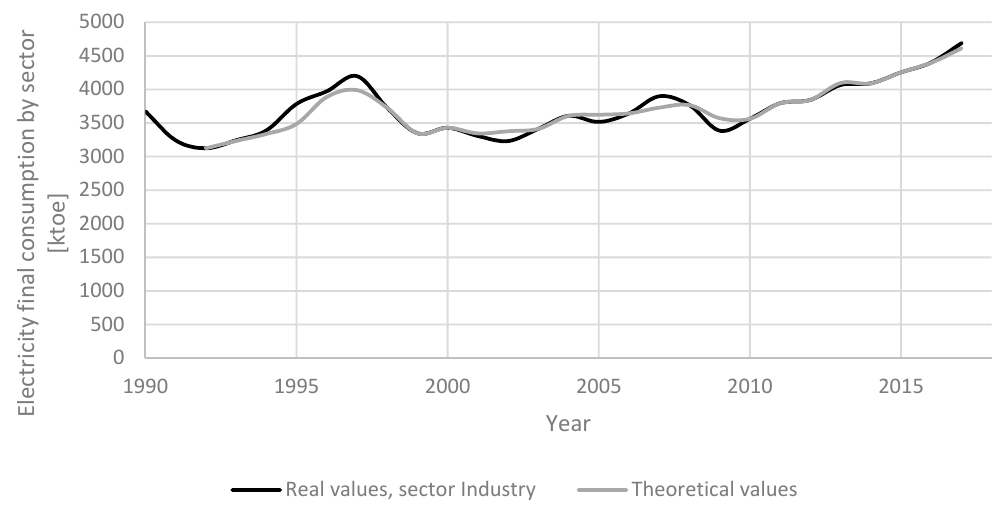
Figure 9. The comparison of the theoretical and actual values of final electricity consumption for transport sector, ktoe, source: own study.